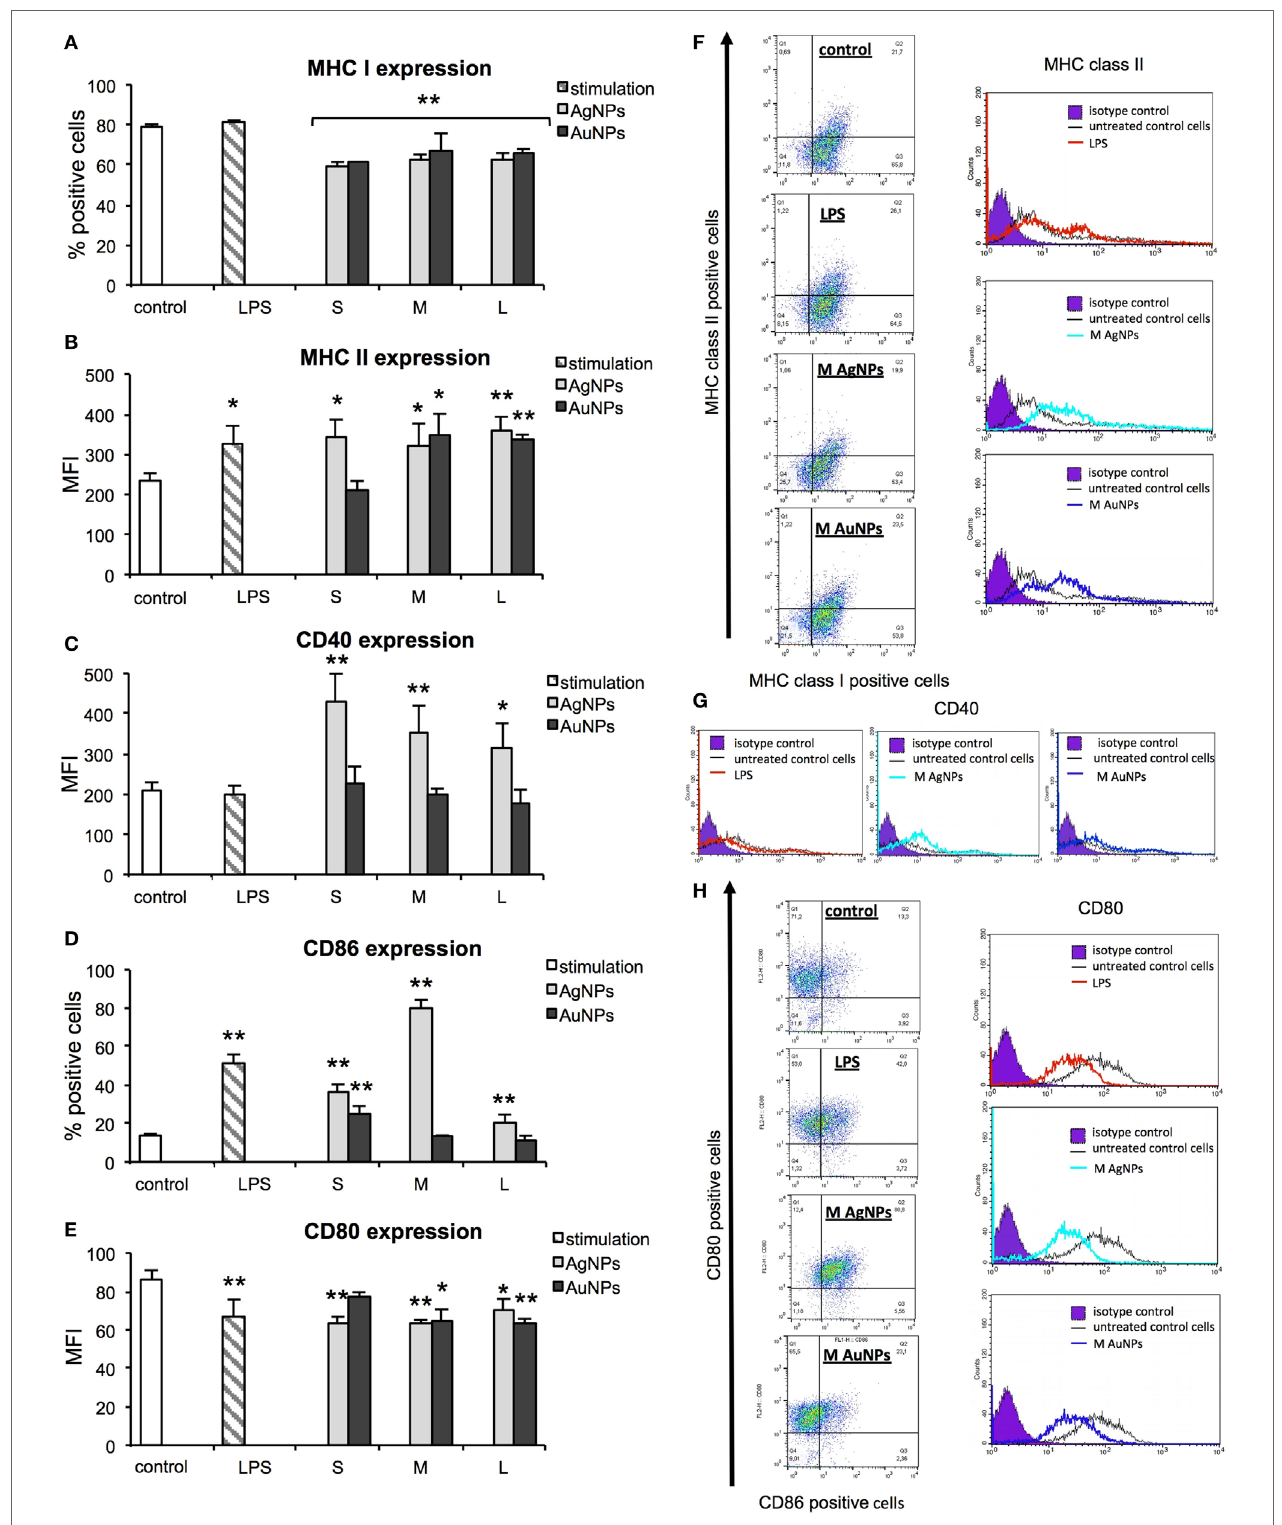
FigUre 6 | Effect of nanoparticles (NPs) on expression of surface activation markers. MHC class I (a) , MHC class II (b) , CD40 (c) , CD86 (D) , and CD80 (e) from 5 experiments ( N = 5) ± S.E.M. (F) Representative dot plots (left panel) for MHC I and MHC II expression and representative histograms for MHC II expression. (g) Representative histograms for CD40 expression. (h) Representative dot plots for CD80 and CD86 expression (left panel) and representative histograms for CD86 expression (right panel). *Significant differences with p ≤ 0.05, ** p ≤ 0.01.